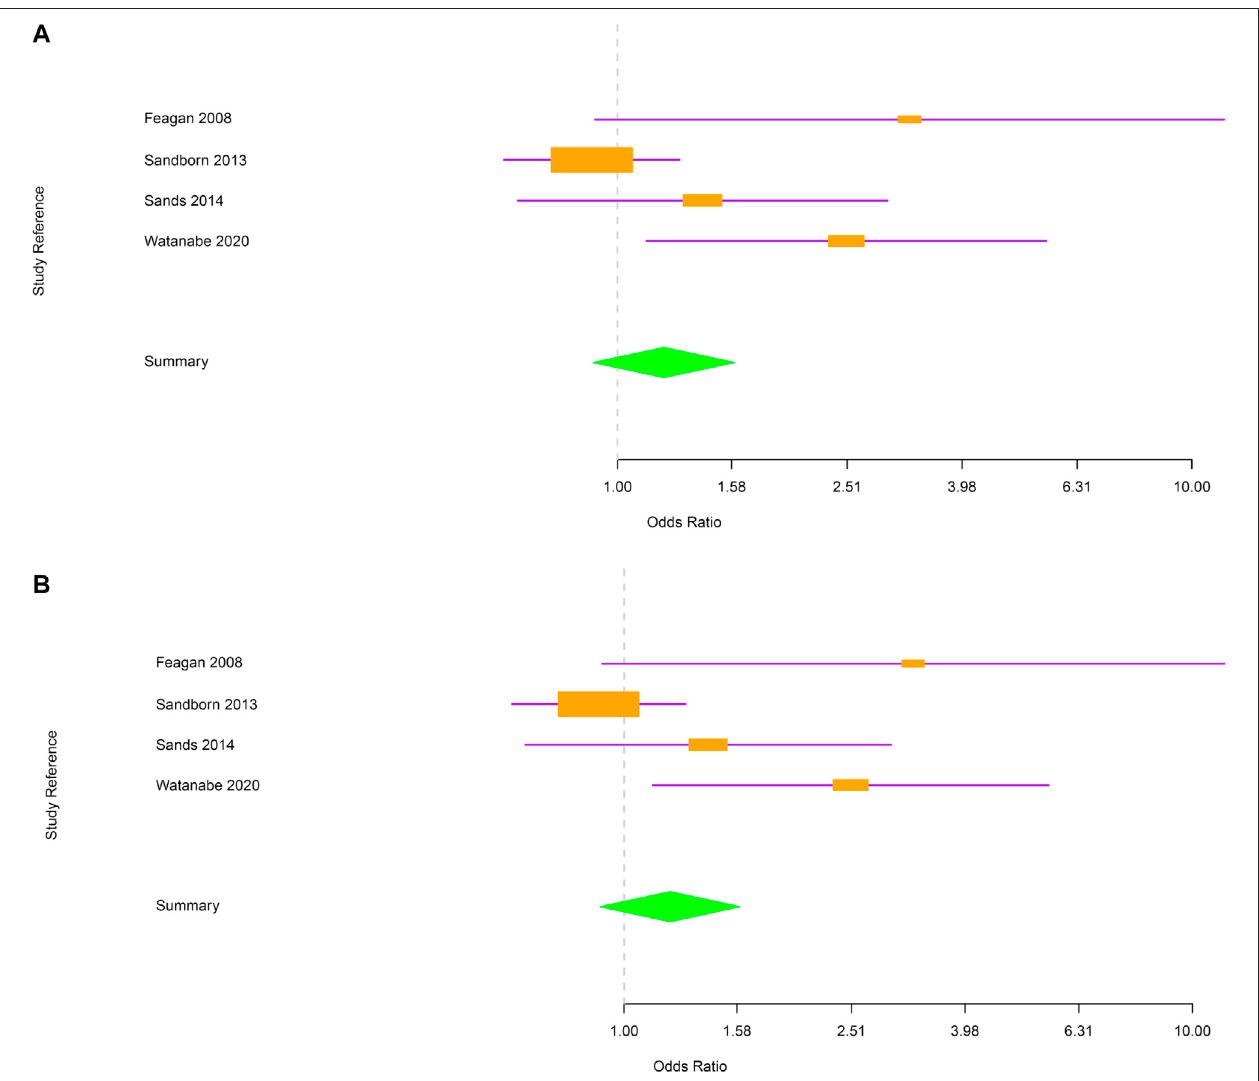
FIGURE 3 | (A) Forest plot for the rate of respiratory tract infections in Crohn ’ s disease patients. (B) Forest plot for the rate of upper respiratory tract infections in Crohn ’ s disease patients.